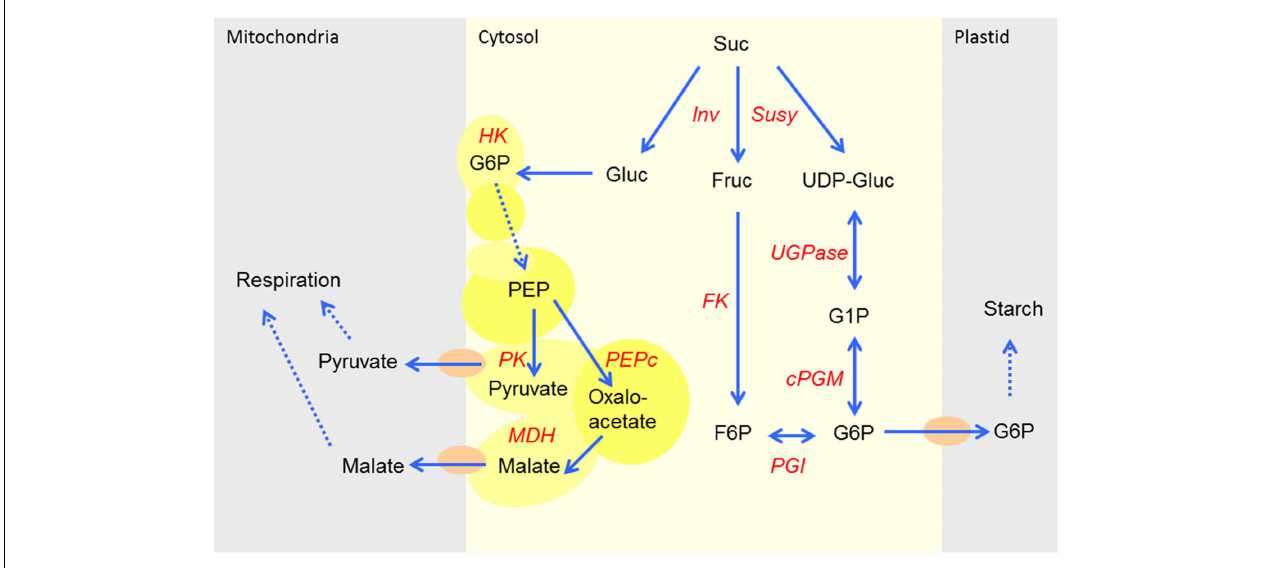
FIGURE 12 | Proposed channeling of glucose toward the glycolysis and respiration with hexokinase as the entry point.